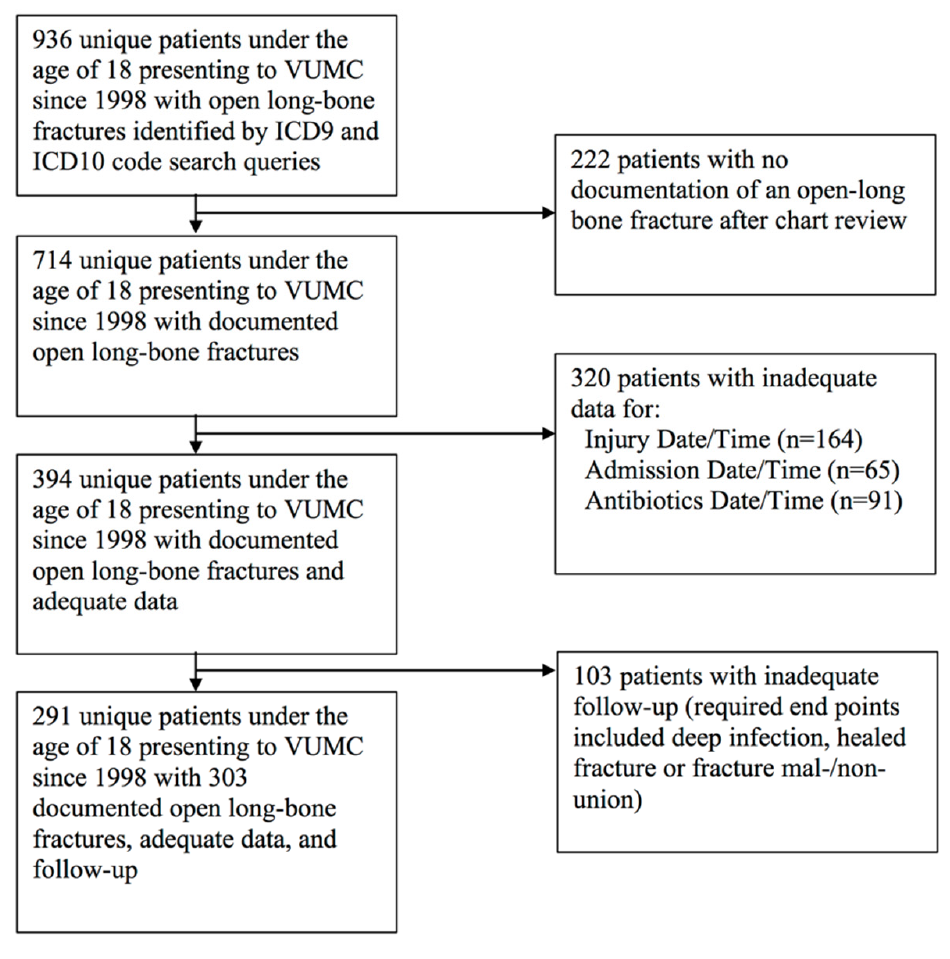
Figure 1. Inclusion and Exclusion